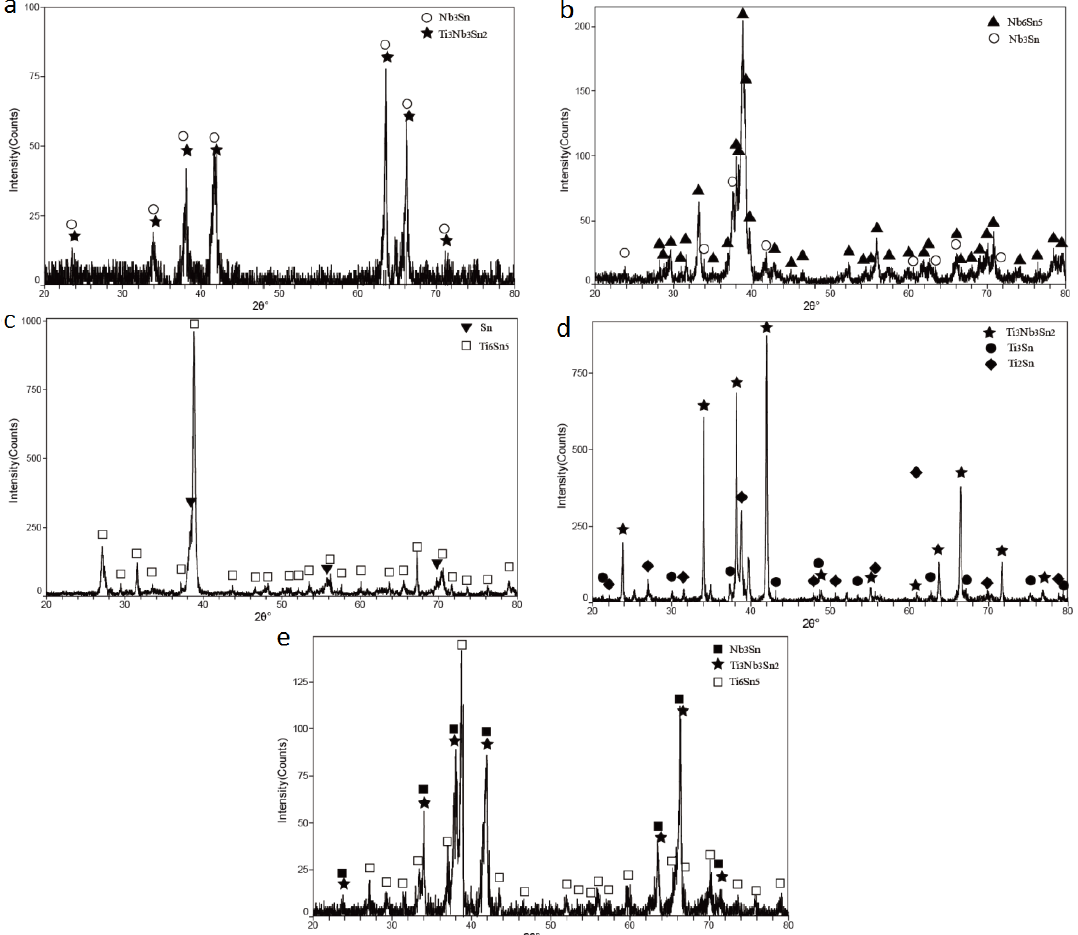
Figure 3. The XRD patterns of typical alloys in Ti-Nb-Sn system annealed at 1173 K for 1440 h. ( a ) Alloy 12; ( b ) Alloy 16; ( c ) Alloy 17; ( d ) Alloy 20; ( e ) Alloy 23.